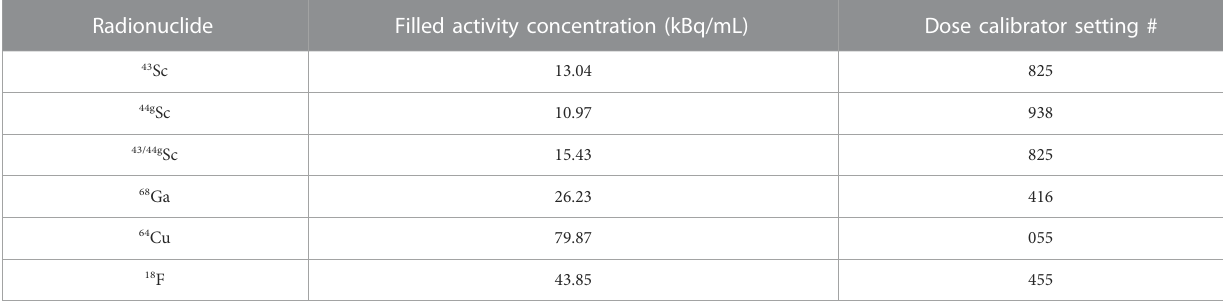
TABLE 3 Filled radioactivity derived from dose calibrator and HPGe recorded radioactivities and measured volumes. Radionuclide Filled activity concentration